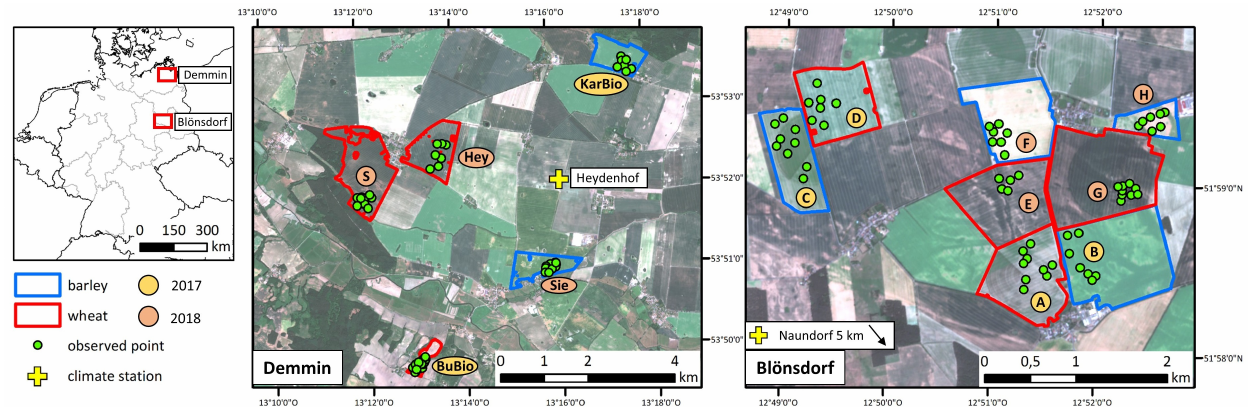
Figure 1. Location of the two test sites DEMMIN (durable environmental multidisciplinary monitoring information network) and Blönsdorf in Germany ( left ) and observed wheat and barley fields with observation points in 2017 and 2018 in Demmin ( center ) and Blönsdorf ( right ): background colors of the field names indicate the year of